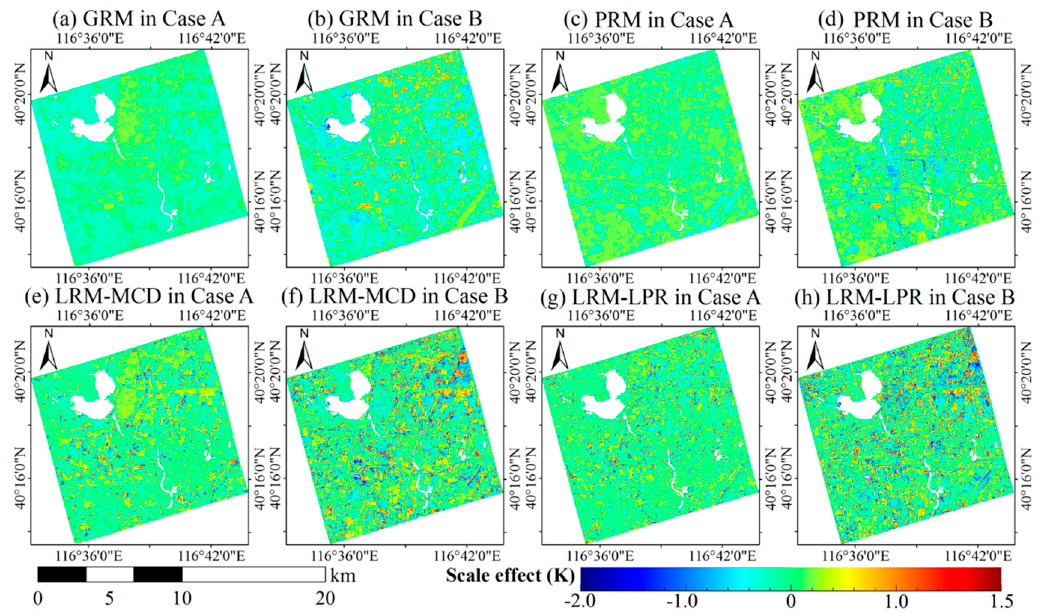
Figure 10. The quantified scale effects in downscaling the Tiangong-1 simulated LST with ( a , b ) GRM, ( c , d ) PRM, ( e , f ) LRM-MCD, and ( g , h ) LRM-LPR.